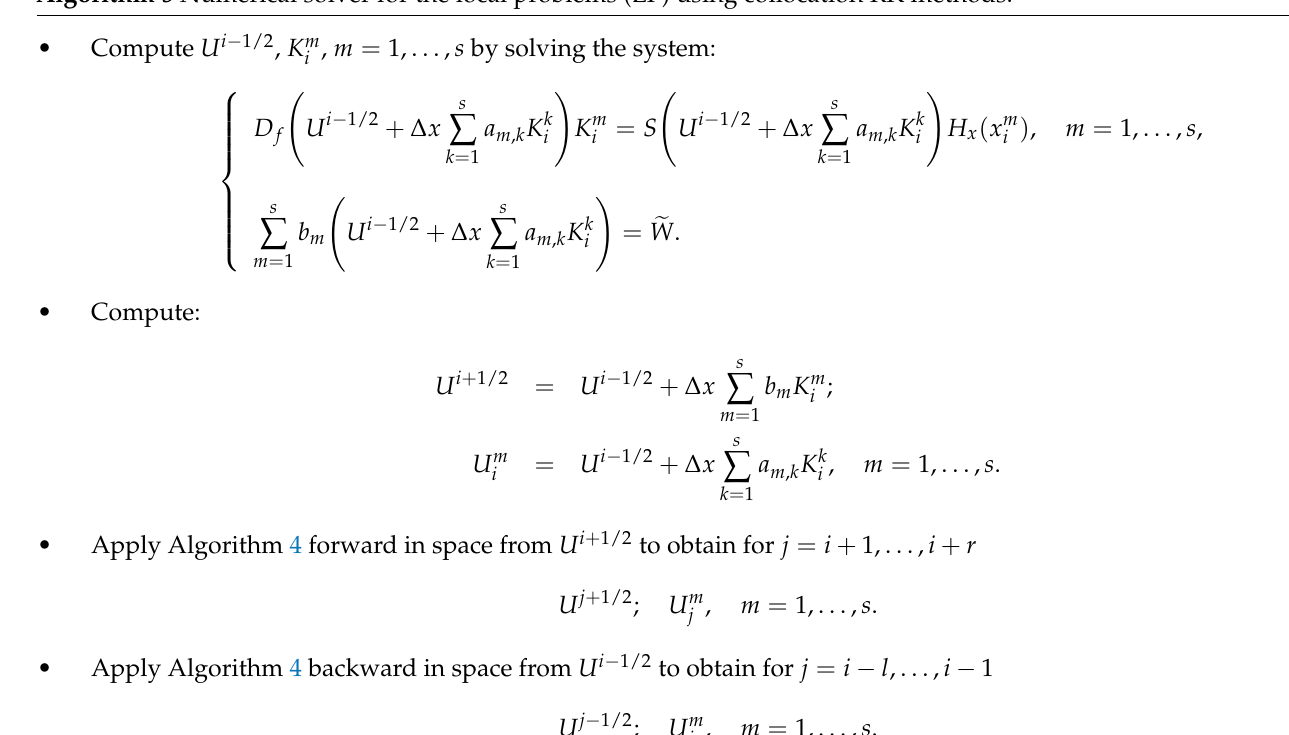
Algorithm 5 Numerical solver for the local problems (LP) using collocation RK